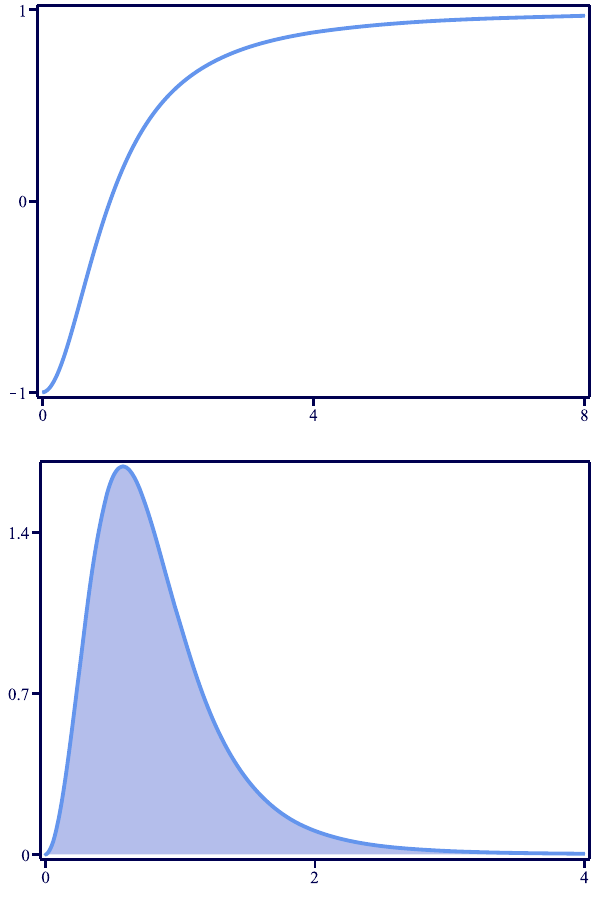
Fig. 1 The solution φ( r ) that appears in (28) (top) and its energy den- sity ρ f ( r ) in (29) (bottom), displayed in terms of the radial coordinate